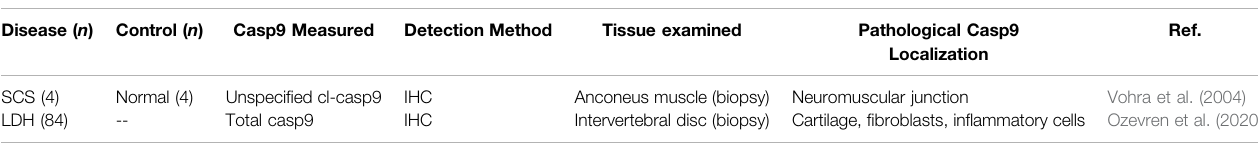
SCS, Slow-channel syndrome; LDH, lumbar disc herniation.